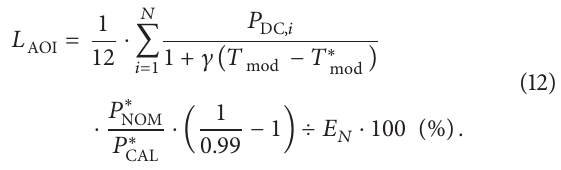
, 𝐿 , 𝐿 𝑃 ∗ ̸=𝑃 ∗ AOI mod CAL NOM